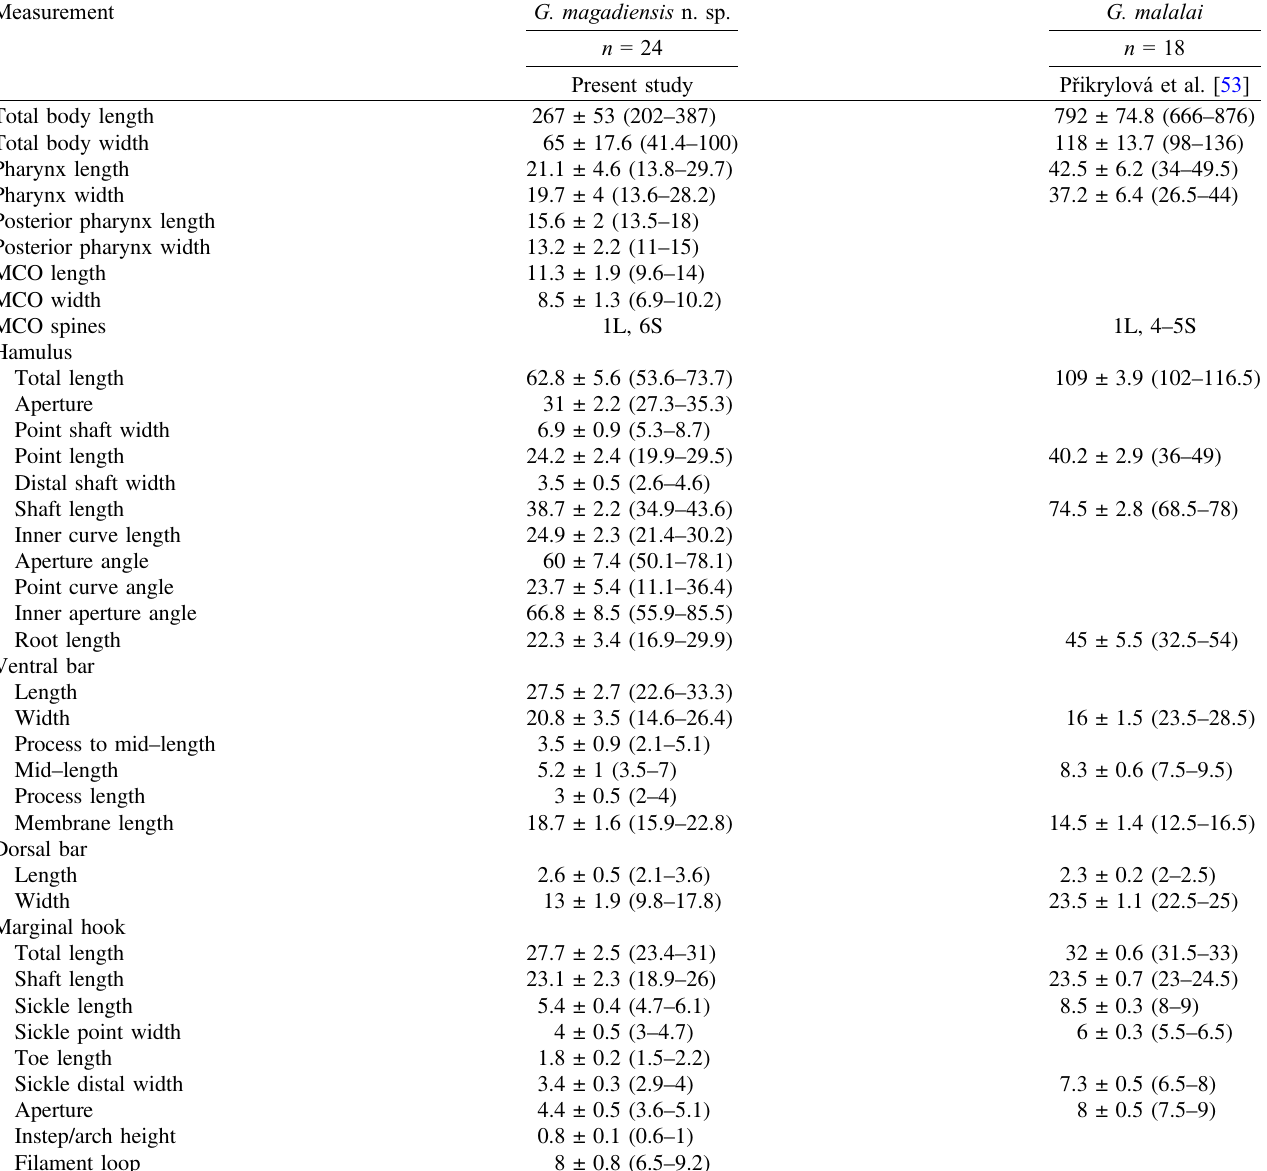
Table 2. Morphological measurements of Gyrodactylus magadiensis n. sp. from the Magadi tilapia, Alcolapia grahami collected from Lake Magadi, Kenya. Data are presented alongside data for the only other previously described Gyrodactylus species from Kenya. Data compiled from previous study directly transposed as noted by